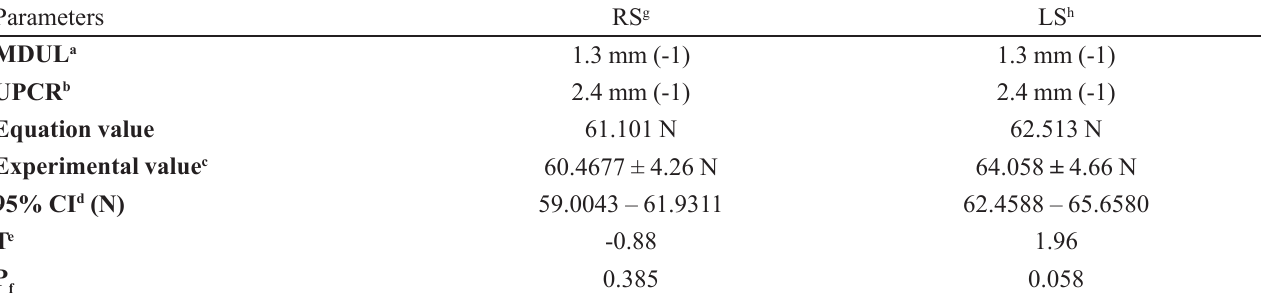
TABLE VIII - Hardness challenge